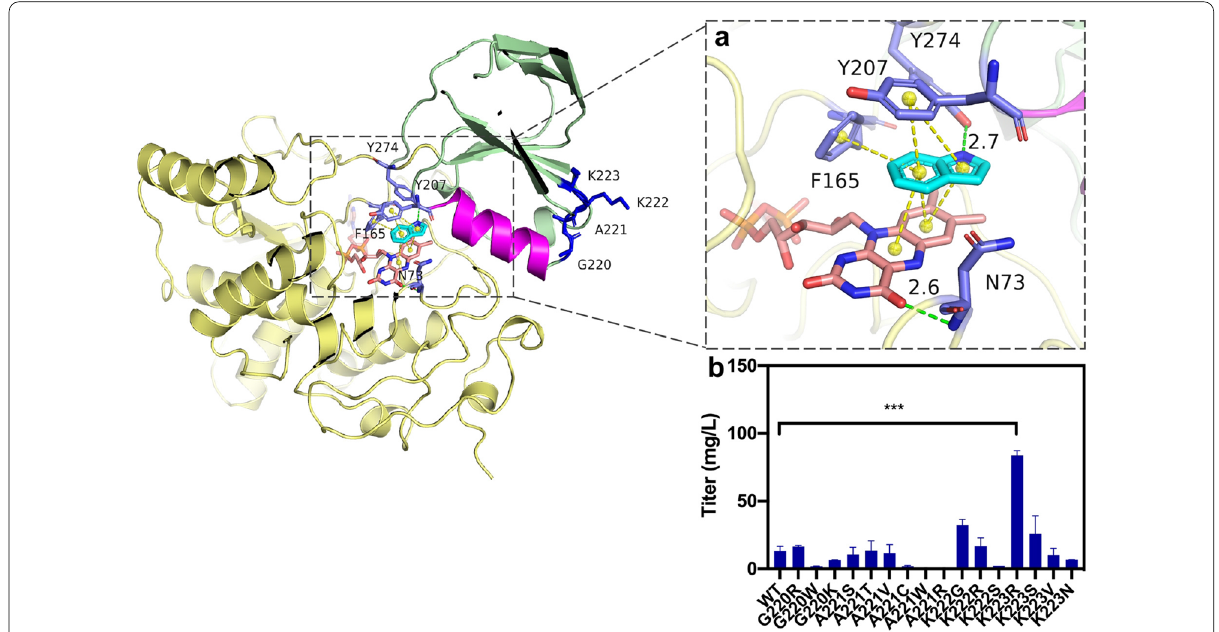
Fig. 4 Docking analysis of the bFMO–indole complex, which shows the location of the α 4 helix (purple) and the loop 220–223 (blue). a π–π stacking interactions of Y207–indole–FAD are indicated by yellow dashed lines, and residues in blue sticks. The F165 is also involved in π–π stacking interaction with indole. Green dotted line indicates hydrogen bond between N73 and FAD. b Indirubin titer of the mutants of bFMO in vivo. Statistical analysis was performed using the Student’s t test (one‑tailed; two‑sample unequal variance; * p < 0.05, ** p < 0.01, *** p < 0.001). All data represent the mean of n 3 biologically independent samples and error bars show the standard =